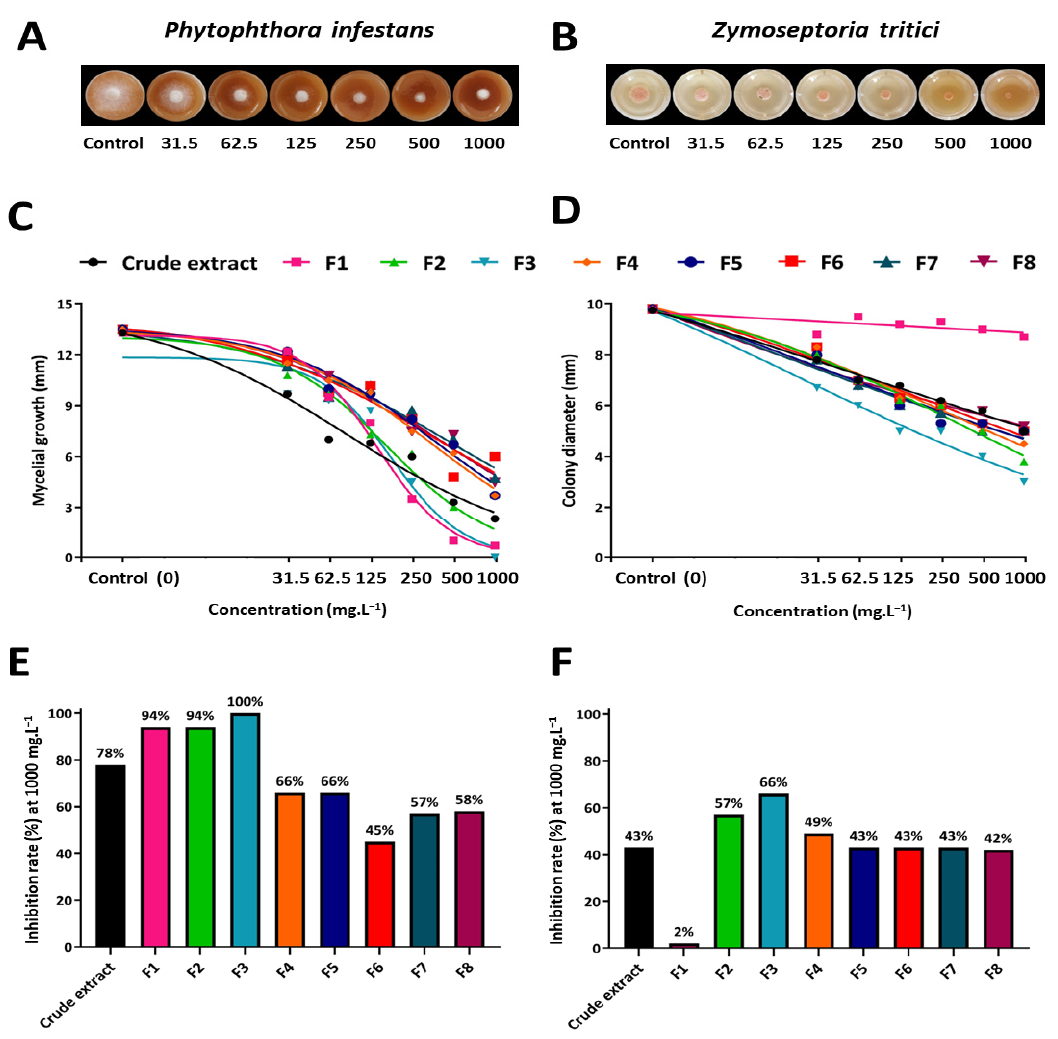
Figure 3. Antimicrobial activity of crude ethanolic extract and fractions from Erismadelphus exsul bark on Phytophthora infestans ( A , C , E ) and Zymoseptoria tritici ( B , D , F ) at three and eleven days after 12-well microplate inoculation with the pathogens, respectively. ( A , B ) illustration of the in vitro growth of P. infestans ( A ) and Z. tritici ( B ) obtained on V8 and PDA mediums, respectively, amended or not with different concentrations of the fraction F3. ( C , D ) Dose-response curves obtained for P. infestans ( C ) and Z. tritici ( D ) using the crude extract and fractions at different concentrations. ( E , F ) Percentage of inhibitions scored for P. infestans ( E ) and Z. tritici ( F ) using the crude extract and fractions at the highest tested concentration of 1000 mg·L − 1 . The X-axis graduation in both ( C ) and ( D ) subfigures is presented in Log2 of the tested concentrations.